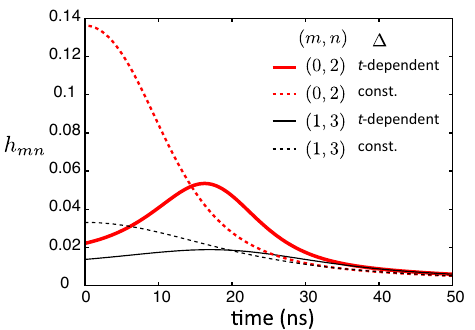
50 ns with the time-dependent =